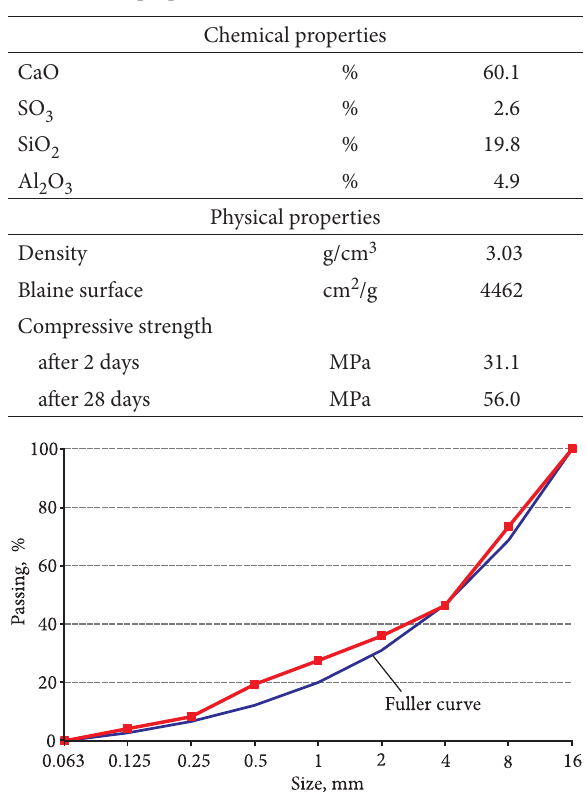
Fig. 1. Aggregate grading curve Table 3. Composition of reference concrete